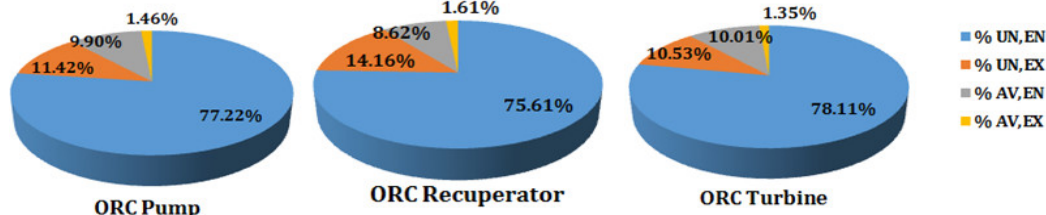
Figure 7. Advanced exergo- environmental destruction rate of each component in the GPP cycle.